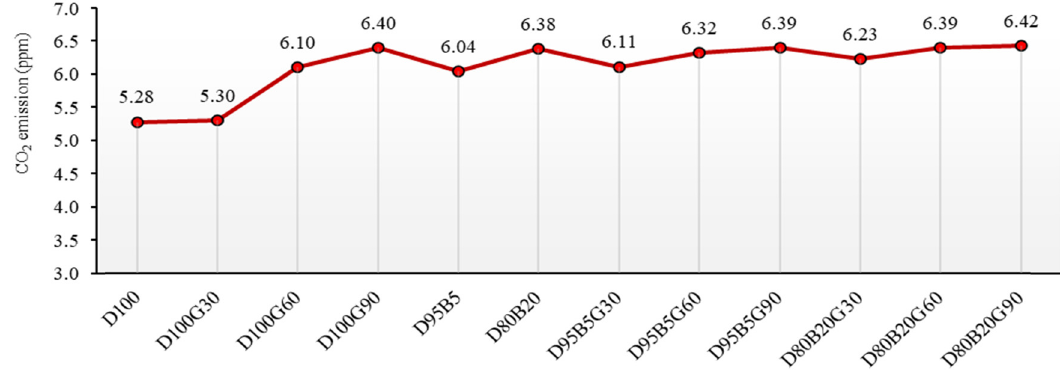
Figure 7: Variations of CO 2 emission for di ff erent fuel blends.